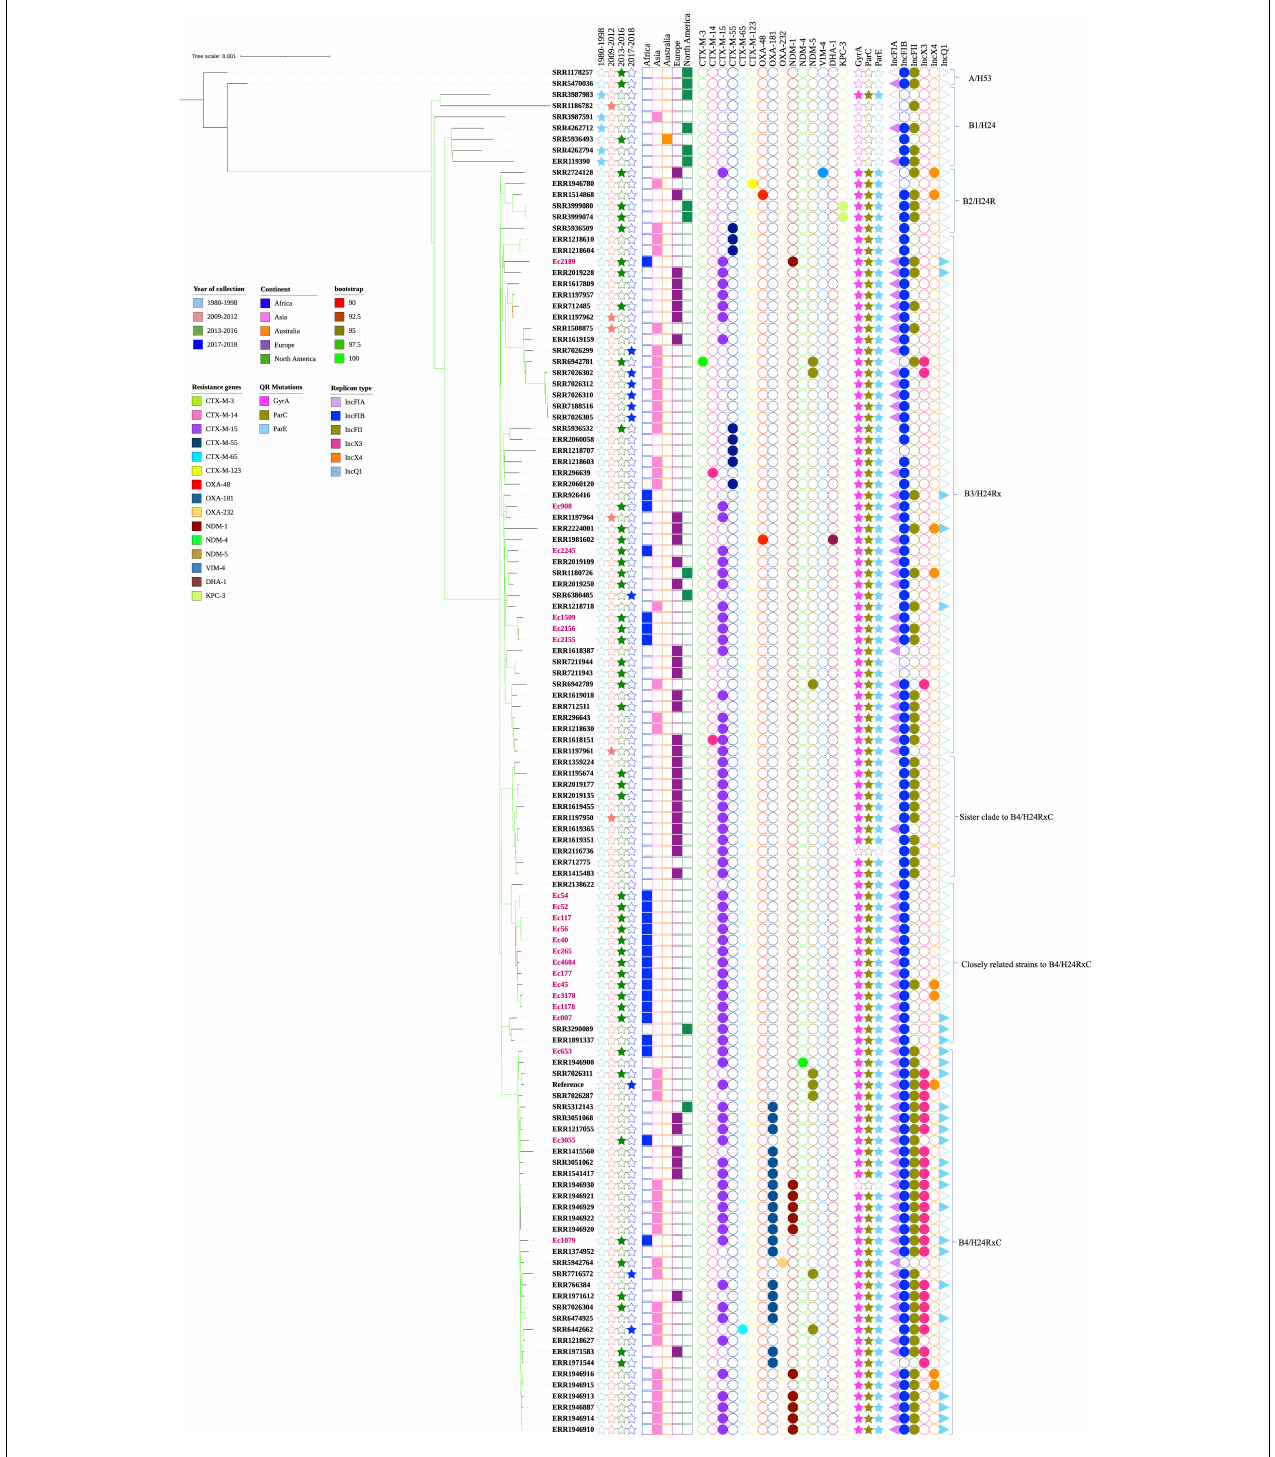
FIGURE 3 | Maximum-likelihood phylogeny of 123 Escherichia coli ST410 strains, 21 (labeled in pink) from Ghana, and 102 global collections sourced from Genbank. The phylogenetic tree was constructed based on single-nucleotide polymorphisms alignment of the core genomes after filtering out recombinant sites. Branch patterns were assessed by 1,000 bootstrap replicates. Bootstrap support values ranging from 90 to 100 are displayed in colors on the branches of the tree. Red color shows minimum and lemon green color shows maximum. Tree shows sub-lineages described within ST410, namely, A/H53, B1/H24, B2/H24R, B3/H24Rx, the sister clade to B4/H24RxC, closely related strains to B4/H24RxC and B4/H24RxC. The year and continents of isolation, resistance genes, QR mutations and plasmid replicon types are indicated by colored regions. Strain IDs of 21 Ghanaian isolates and accession numbers of the other 102 strains are labeled at the